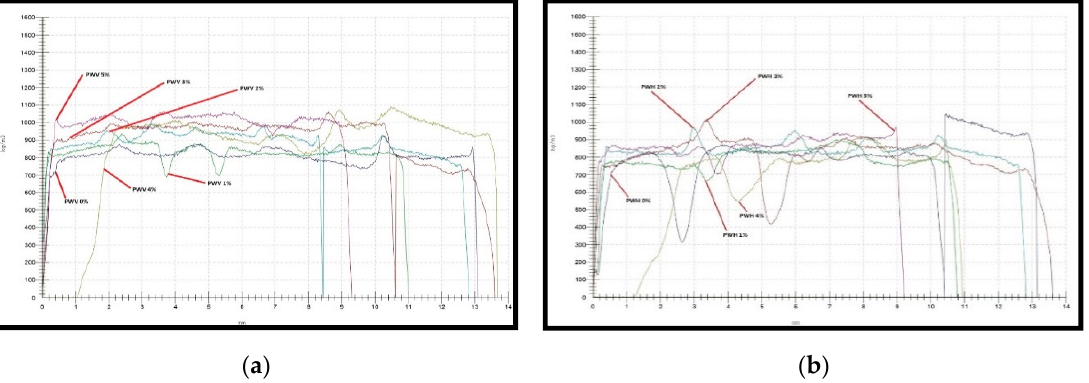
Figure 4. Density profile of ( a ) PWV and ( b ) PWH with di ff erent loading of PF resin-filled oil palm (OP) nanoparticles.